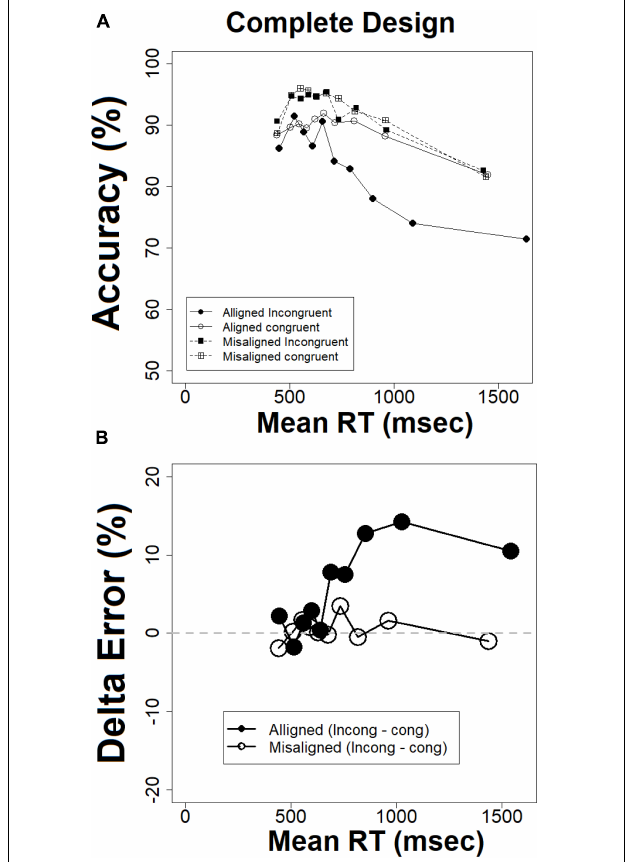
FIGURE 8 | (A) Conditional accuracy functions for the complete design, (B) delta plots for error rates in the complete design, the abscissa = (mean RT congruent + mean RT